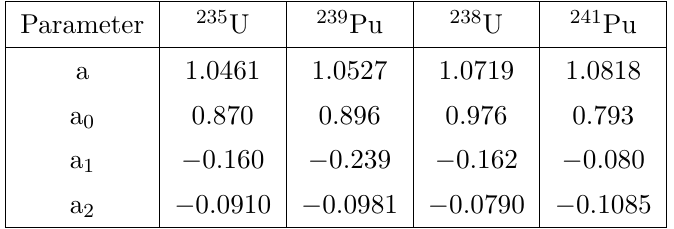
Table 2 . Fitted parameters of the antineutrino spectrum of each (cid:12)ssile isotope. Process Relative rate per (cid:12)ssion